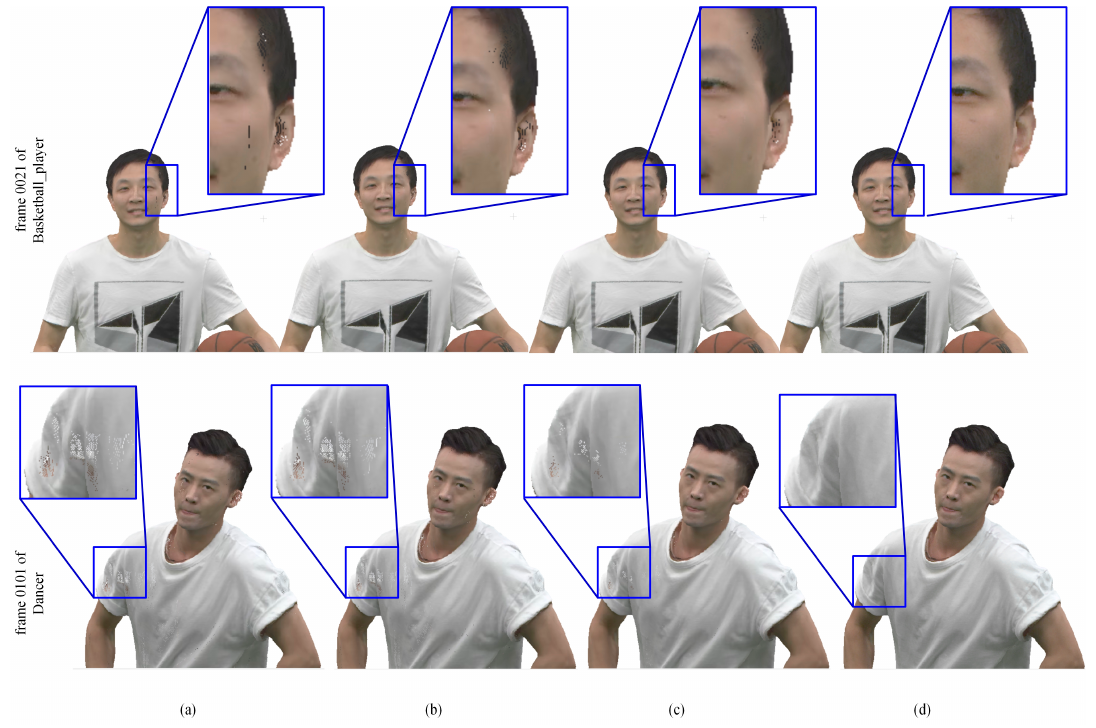
Figure 14. Results for subjective inspection in Owlii dataset: ( a ) V-PCC with voxDim of 2; ( b ) V-PCC with voxDim of 4; ( c ) compressed by the curvature-grading-based refining method; ( d ) the original point clouds.